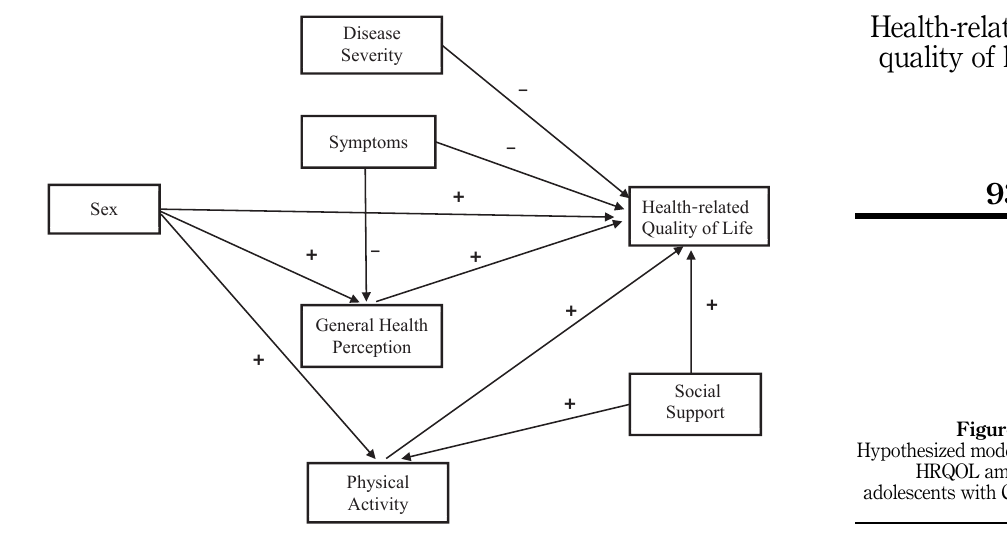
Figure 1. Hypothesized model of HRQOL among adolescents with